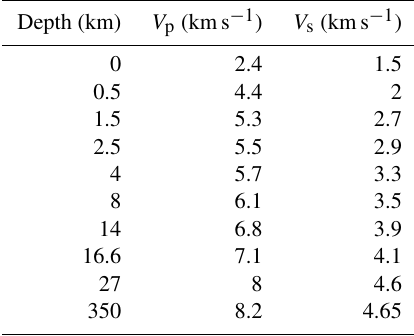
56 stations where PGV re- Figure 2. A virtual network of N obs = sponses are reported by the source model. The solid black line at the center denotes the length and location of the fault plane. Note that the 56 stations are grouped into four sets (indicated by differ- ent colors/symbols) according to their R JB distances (see details in Sect. 4). Table 1. Velocity model used in this study, modified from Boore et al. (1997).